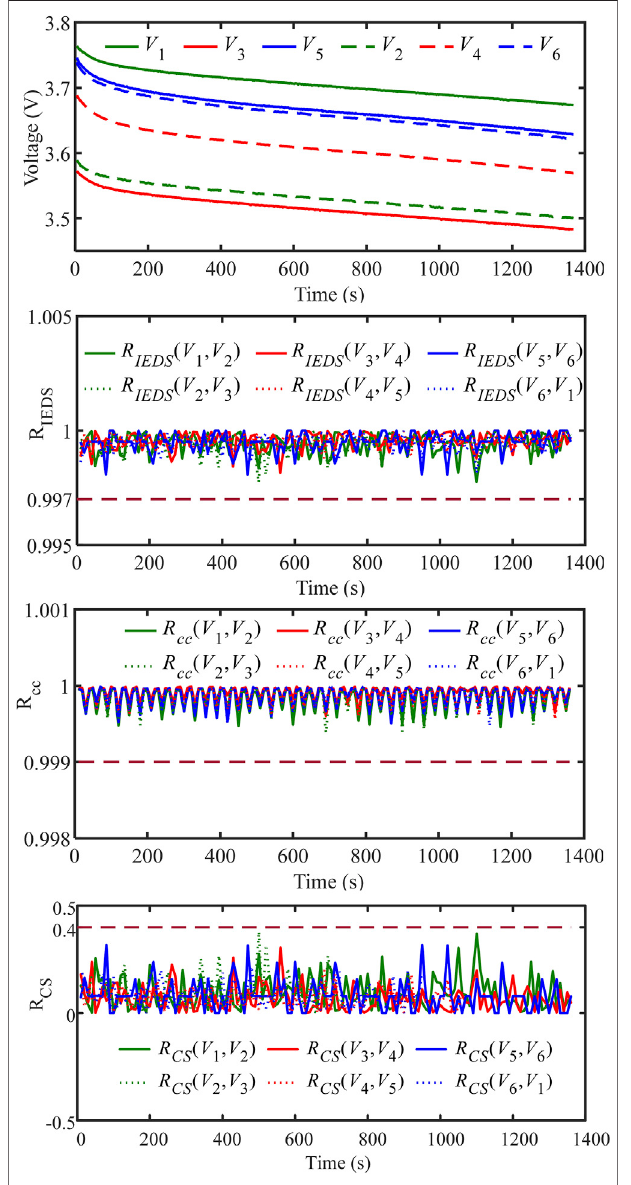
FIGURE 8 | Connection fault evaluation results. (a) Voltage curve. Diagnosis by (b) R IEDS , (c) R cc , (d) R CS